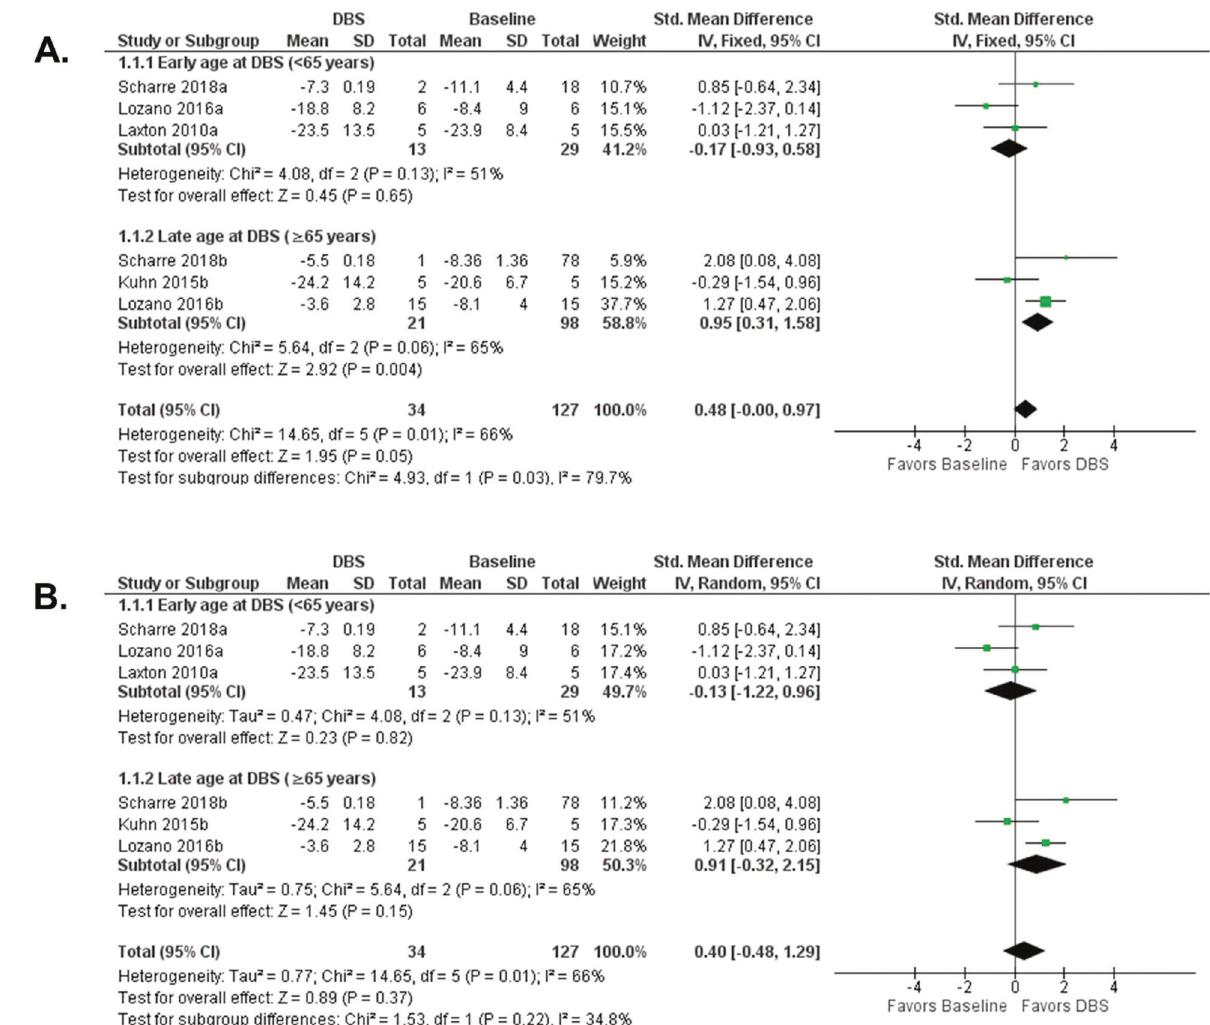
Fig. 3 Subgroup analysis forest plots. A Fixed-effect model subgroup meta-analysis of cognitive outcome in early age at DBS ( < 65 years old) and late age at DBS ( ≥ 65 years old). B Random-effects model subgroup meta-analysis of cognitive outcome in early age at DBS ( < 65 years old) and late age at DBS ( ≥ 65 years old). AD, Alzheimer ’ s disease; CI, con fi dence interval; DBS, deep brain stimulation; IV, inverse variance; SD, standard deviation.